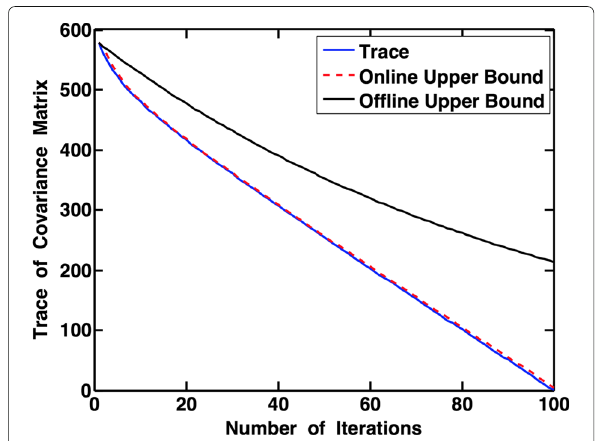
Fig. 2 One-step ahead prediction for the trace of the covariance matrix: the offline bound corresponds to applying (10) iteratively k times, and the online bound corresponds to predicting tr ((cid:2) k ) using tr ((cid:2) k − 1 ) . Here n = 100, p = 0.95, ε = 0.1, (cid:2) = dd (cid:2) + 5 I n where d = [1, ··· ,1]